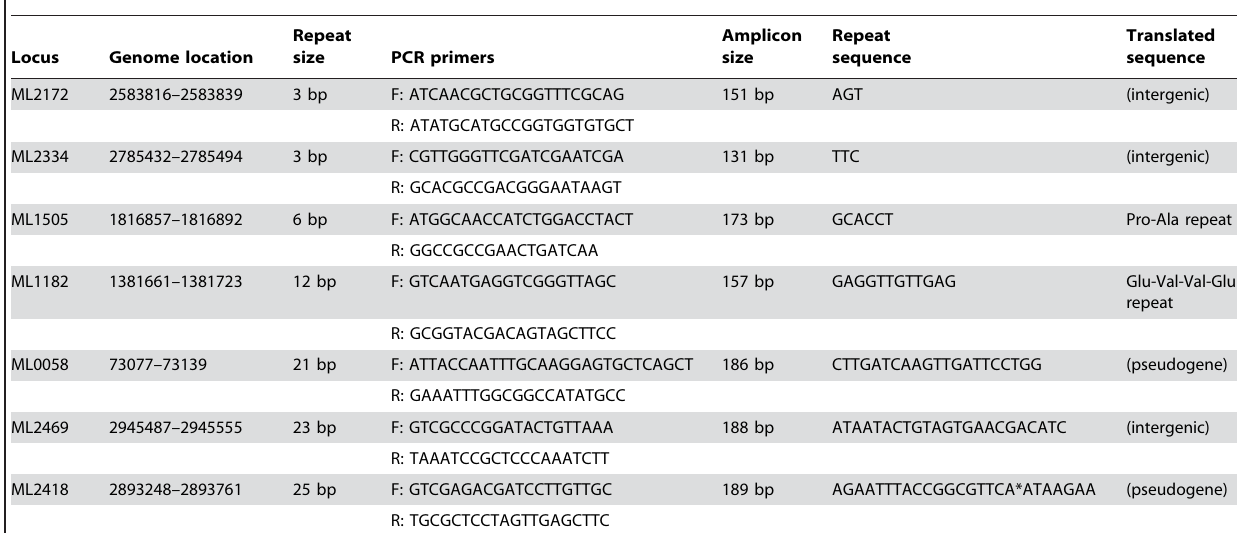
Table 1. Short tandem repeat loci and PCR primers employed in this study, and their size in base pairs (bp).